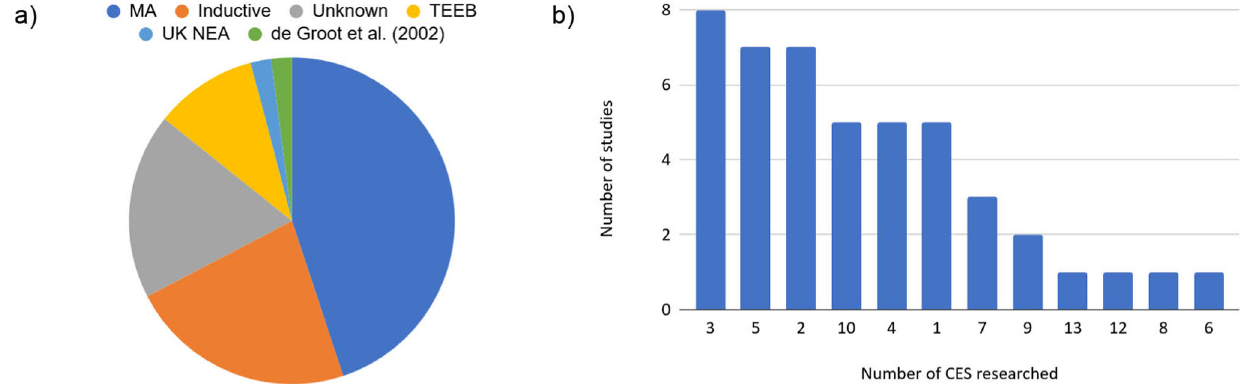
Fig. 5 Characteristics of case studies presenting CES classi fi cation used, number of CES addressed. a Proportion of case studies distinguished by the type of CES classi fi cation used. b Number of CES categories researched per study.